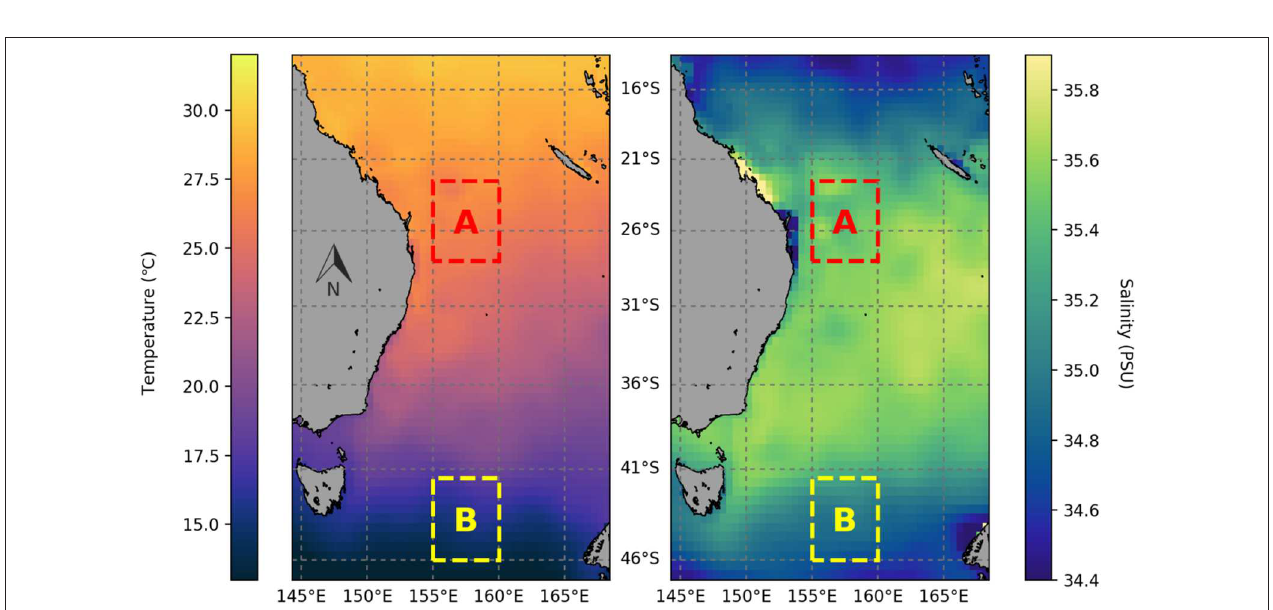
FIGURE 3 | Example of data from the “CSIRO Atlas of Regional Seas” (CARS) showing surface temperature ( ◦ C) (left) and Salinity (PSU) (right) for the east coast of Australia. The mean state for the 15th day of February is shown as an example. These data were used to train the logistic regression model for the classification algorithm with box “A” representing the region used to train subtropical origin (STO) water and box “B” representing the region used to train Tasman Sea origin (TSO)